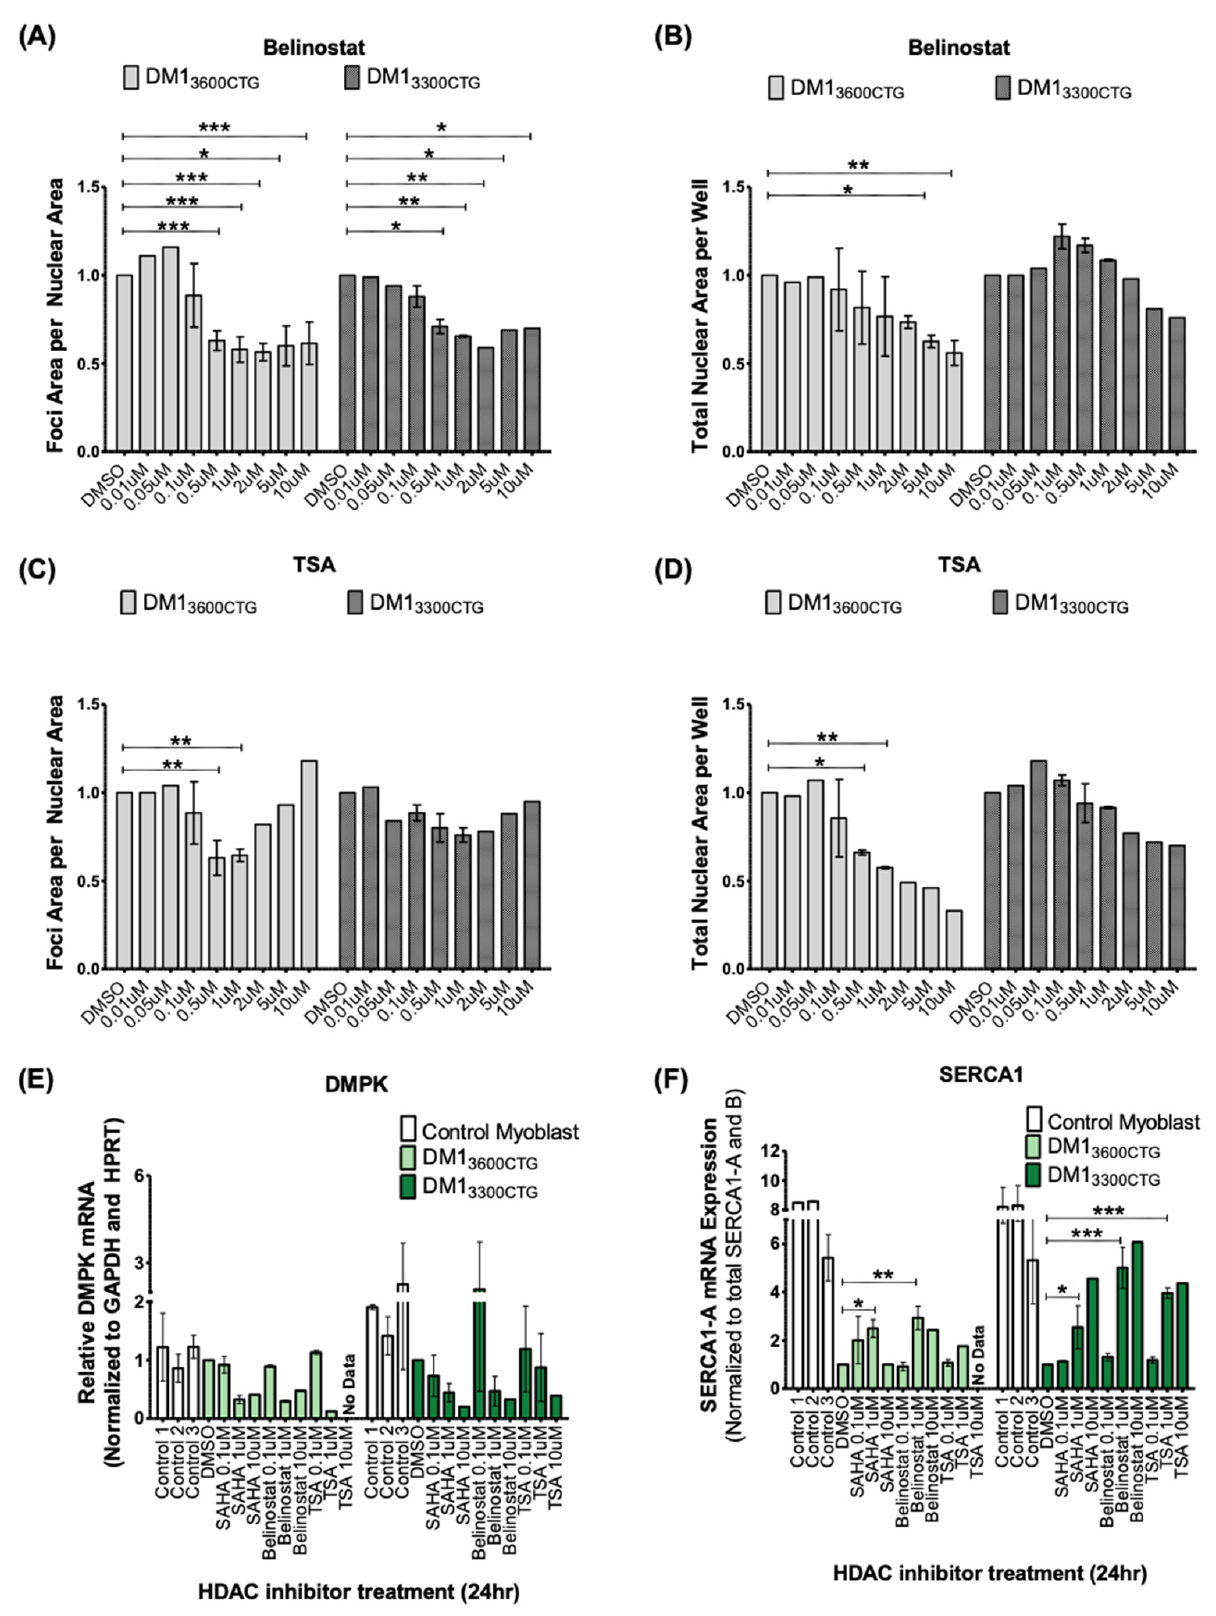
Figure 5. Two additional pan-HDAC inhibitors, belinostat and trichostatin A (TSA), were validated to reduce foci, decrease DMPK mRNA, and rescue SERCA1 splicing in differentiated DM1